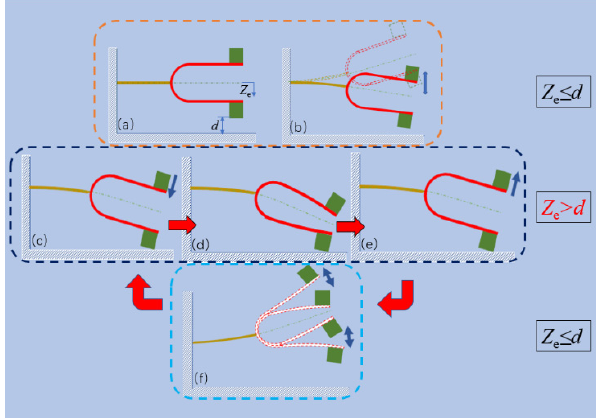
Figure 3. Motion location of the tuning fork energy harvester. ( a ) Stationary state, ( b ) small amplitude vibration, ( c ) impact, ( d ) the maximum deformation, ( e ) the moment of separation from the impact surface, and ( f ) the vibration of the tuning fork arm after it is separated from the impact surface.